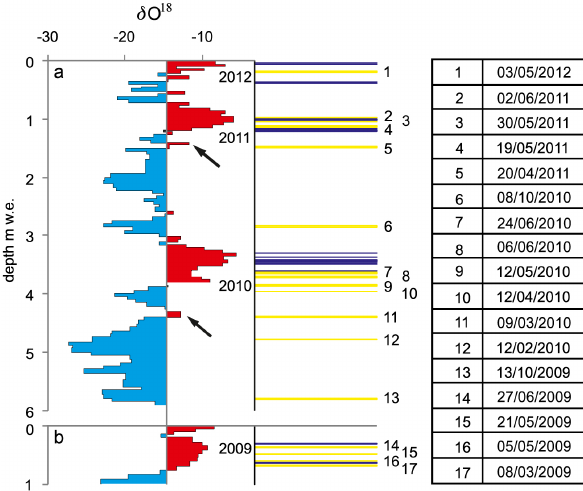
Fig. 2. Oxygen ( δ 18 O) isotopic record and stratigraphy for (a) the shallow core and (b) the snow pit. Dust layers and ice crusts are shown in yellow and blue respectively. Dust deposition events are numbered from 1 (the most recent) to 17 (the earliest in the record). Dates of deposition events are shown in the table. Arrows point at the short-term increases in δ 18 O corresponding to the advection of warm air masses transporting dust (Sect. 3.1). Depth is shown in metres of water equivalent